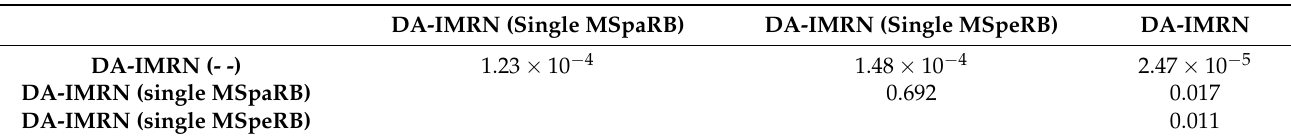
Table 9. Results of two-tailed Wilcoxon’s tests over per-class accuracy for the proposed MSpaRB , MSpeRB and complete